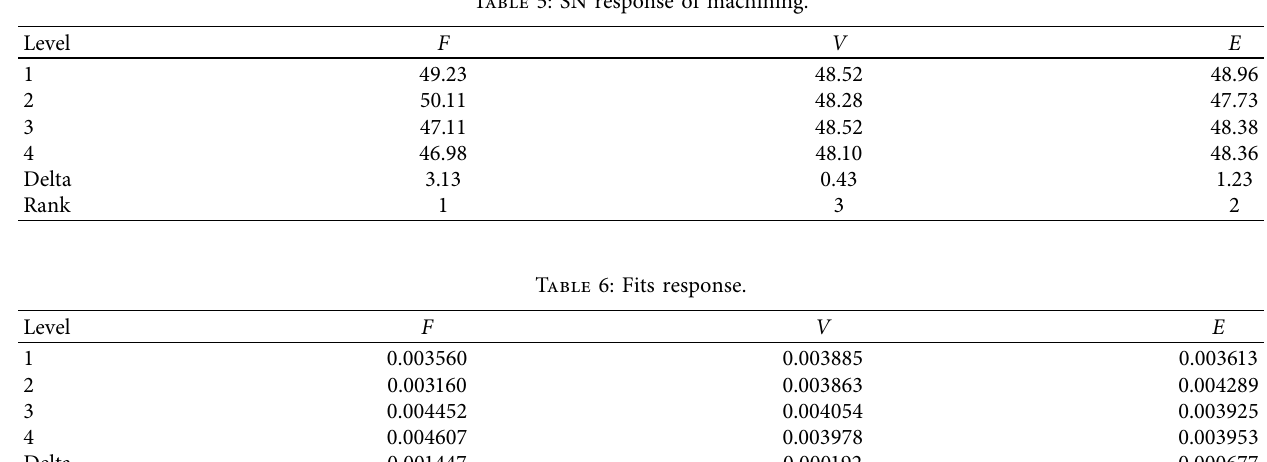
Table 5: SN response of machining.